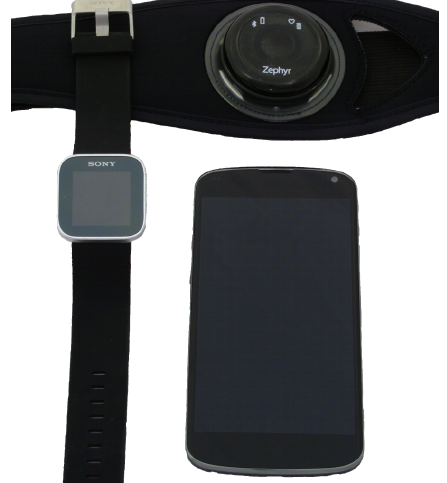
Figure 3. The apparatus: Zephyr BioHarness 3 (top), Sony SmartWatch (left) and LG Nexus 4